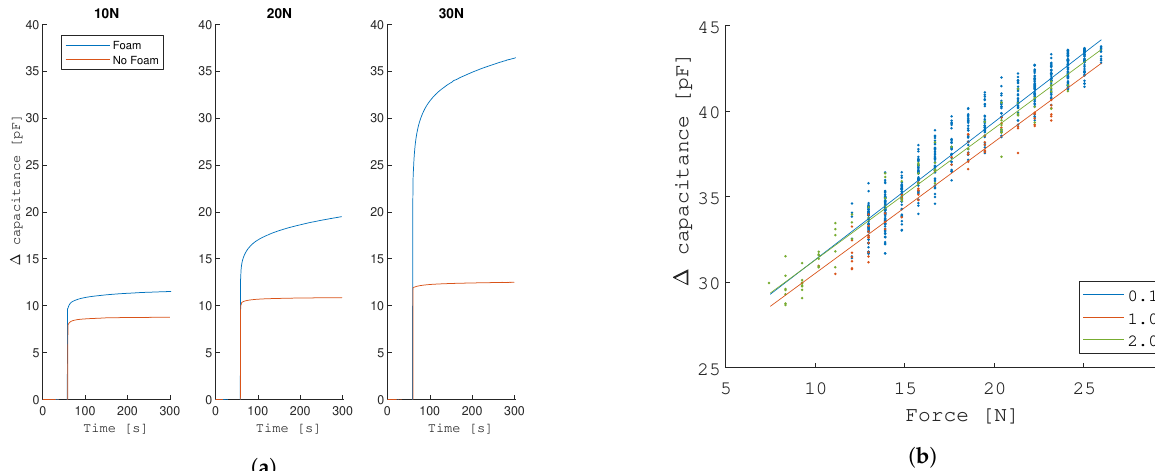
Figure 7. Test-bench characterization results (A): Adding foam on top of the sensor affects the response of the sensor significantly, since the load is more evenly distributed on the plate. No strong frequency-dependency of the response is observed. ( a ) Effects of adding foam on top of the sensor to improve uniformity of applied loads. Three loads (1 kg, 2 kg and 3 kg) are placed onto the sensor. ( b ) Effects of adjusting the frequency of the